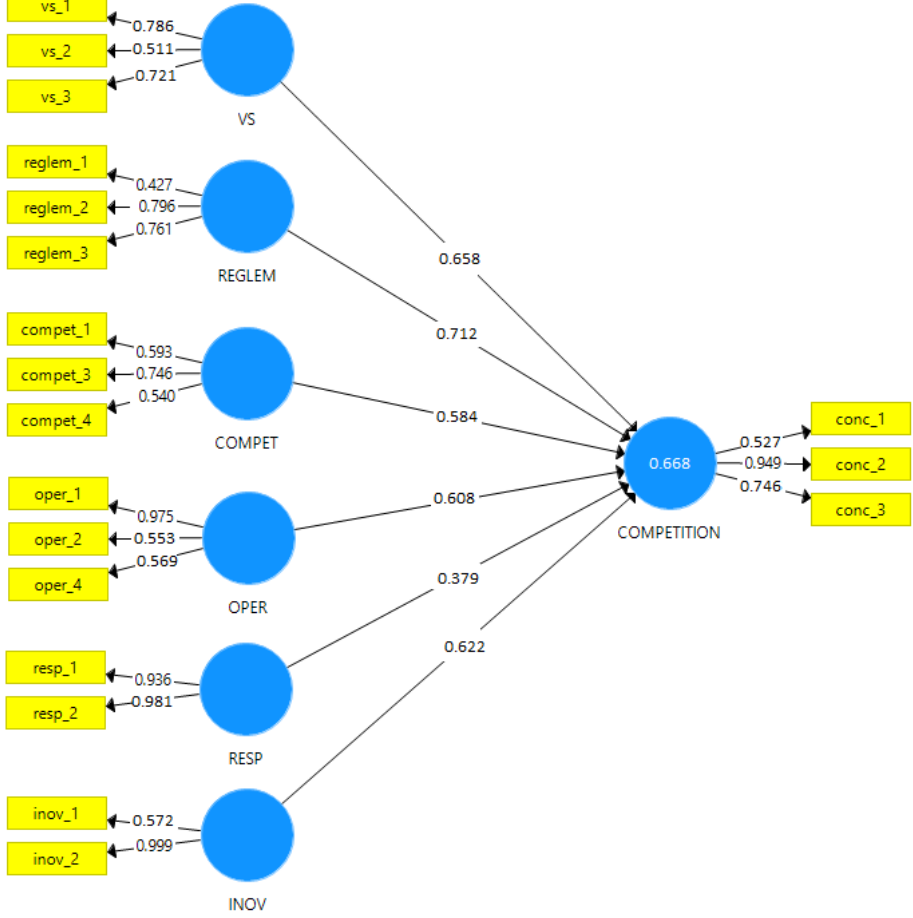
Figure 4. Measurement PLS-SEM 2 model. Source: Data analysis was performed by the authors using the SmartPLS software